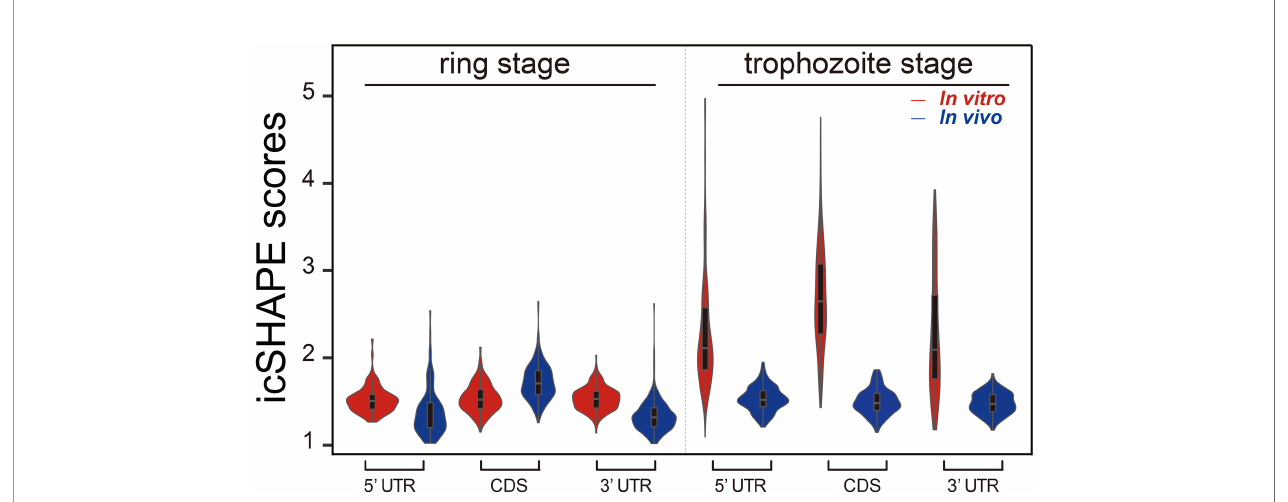
FIGURE 3 | icSHAPE reveals new features of mRNA secondary structures that located 5-UTR, CDS region and 3-UTR region in vivo and in vitro. The average icSHAPE score in vivo and in vitro across the CDS regions and UTR regions to quantify the distribution of icSHAPE reactivity pro fi les in the trophozoite stage development. The fi gure showed that RNAs are less folded in vivo (low icSHAPE scores), and the extent of unfolding varies in different regions of RNAs. The 5 ’ UTRs exhibited noticeable but partial unfolding, with the largest variation compared to the CDS regions and 3 ’ UTRs. Those three different regions of RNAs have nearly the same icSHAPE scores in vivo , but the CDS region have the highest icSHAPE scores than the 5 ’ UTR and 3 ’ UTR when the RNA structure were modi fi ed in vitro